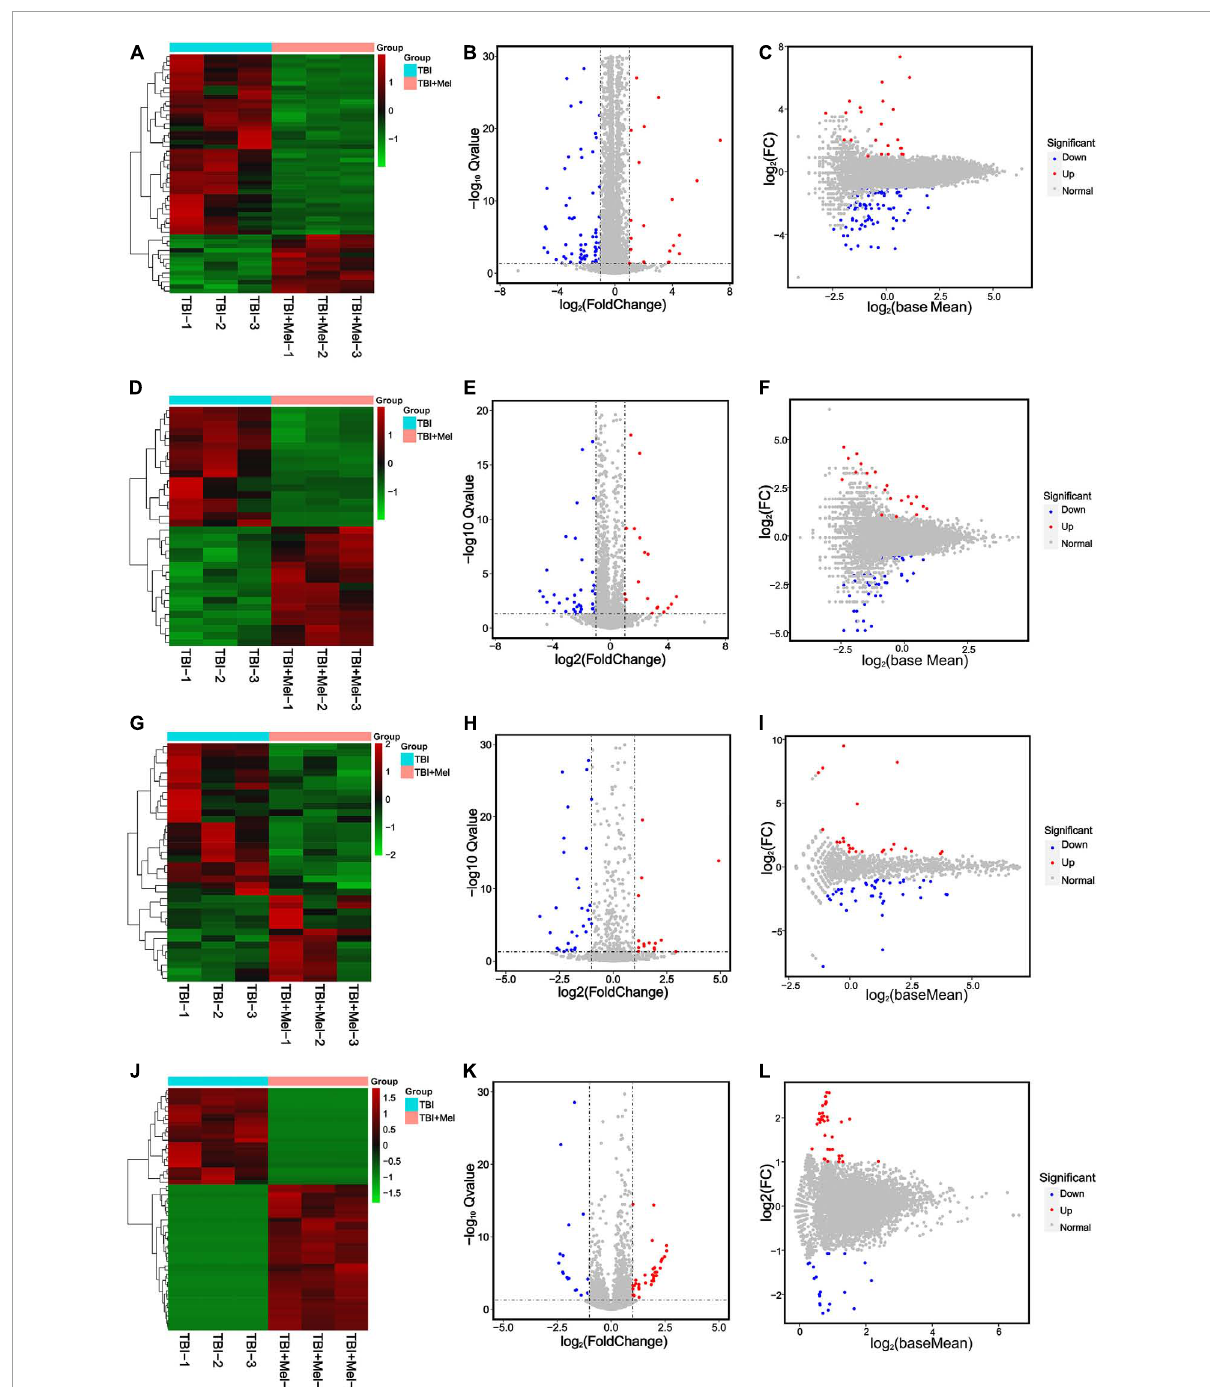
FIGURE2 RNA-seq reveals different expression patterns of mRNAs, lncRNAs, miRNAs, and circRNAs in TBI and TBI + Mel group mice samples at 3 days. (A–C) Clustering analysis heatmap (plotted by selected DEmRNAs that expression level is relatively stable within groups), volcano plot and MA plot of DEmRNAs between TBI and TBI + Mel group. TBI-1, TBI-2, and TBI-3 represent three repetitions of untreated brain injury mice. TBI + Mel-1, TBI + Mel-2, and TBI + Mel-3 represent three repetitions of TBI mice treated with melatonin. (D–F) Clustering analysis heatmap (plotted by selected DElncRNAs that expression level is relatively stable within groups), volcano plot and MA plot of DElncRNAs between TBI and TBI + Mel group. (G–I) Clustering analysis heatmap (plotted by selected DEmiRNAs that expression level is relatively stable within groups), volcano plot and MA plot of DEmiRNAs between TBI and TBI + Mel group. (J–L) Clustering analysis heatmap (plotted by selected DEcircRNAs that expression level is relatively stable within groups), volcano plot and MA plot of DEcircRNAs between TBI and TBI + Mel